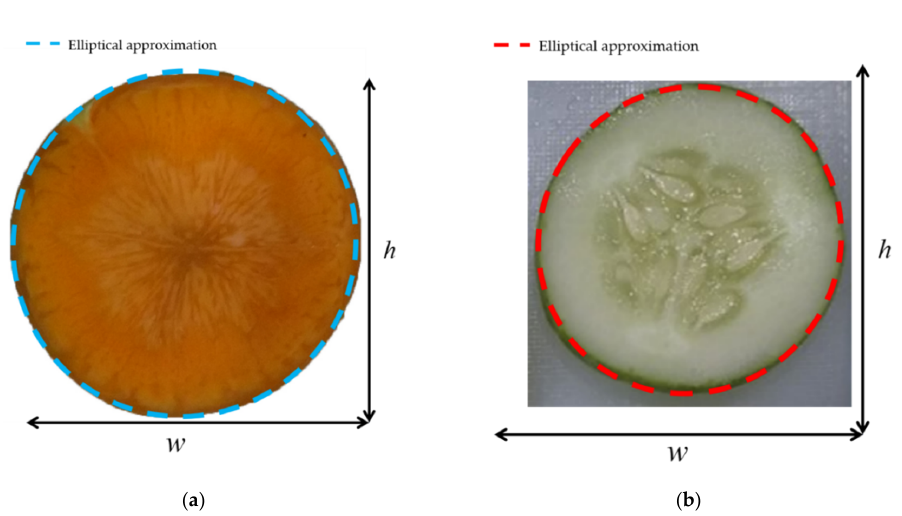
Figure 12. Elliptical representation of the cross-section of: ( a ) a carrot and ( b ) a cucumber.